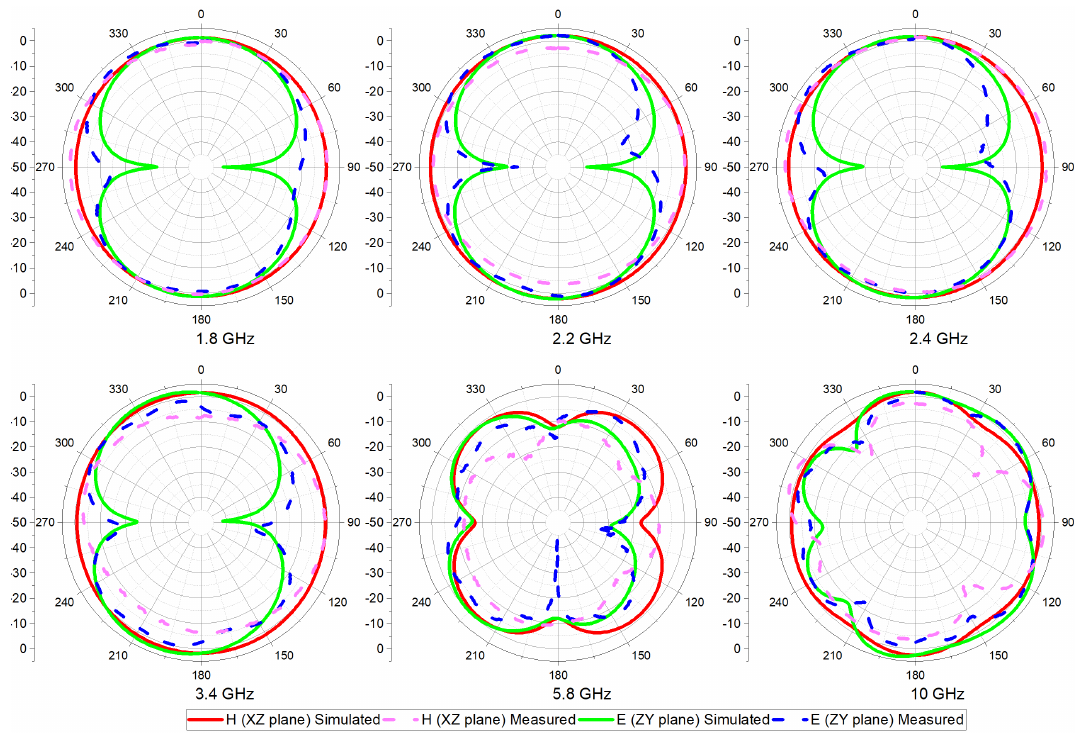
Figure 13. Measured and simulated radiation patterns in the E-plane and